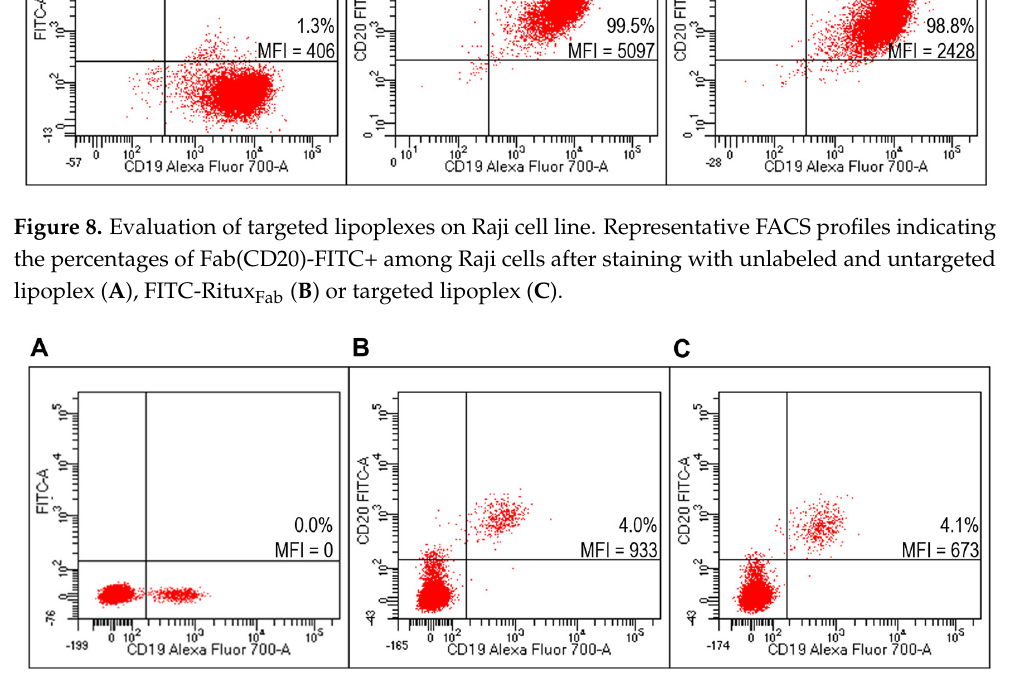
Figure 9. Evaluation of targeted lipoplexes on HD PBMC. Representative FACS profiles indicating the percentages of Fab(CD20)-FITC+ among lymphocytes after staining with unlabeled and untargeted lipoplex ( A ), FITC-Ritux Fab ( B ) or FITC-Ritux Fab lipoplexes ( C ). By using targeted lipoplex labeled with 1,2-dioleoyl-sn-glycero-3-phosphoethanola-